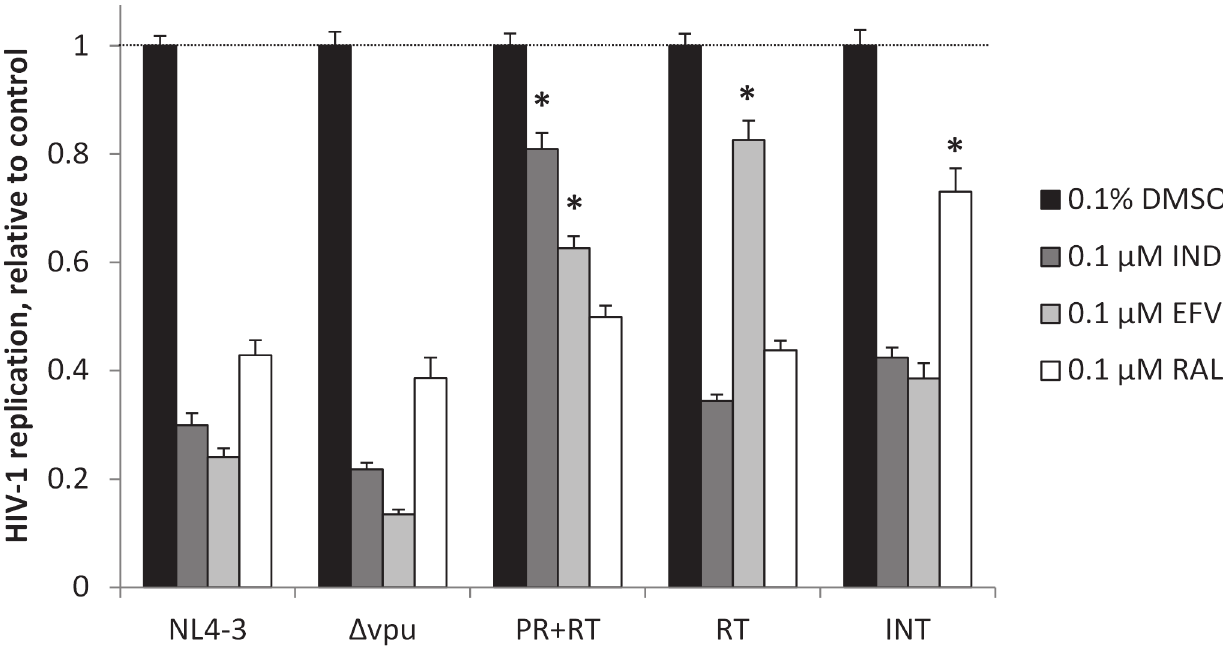
Fig 4. Replication of HIV-1 NL4-3 , HIV-1 Δ vpu , and drug-resistant HIV-1 strains in CEM-GXR cells. Data shown are at Day 4 in the presence of 0.1 μ M of established ARVs, relative to the replication rate of each HIV-1 strain in the presence of 0.1% DMSO vehicle control. * , p < 0.004 vs. HIV-1 NL4-3 replication.